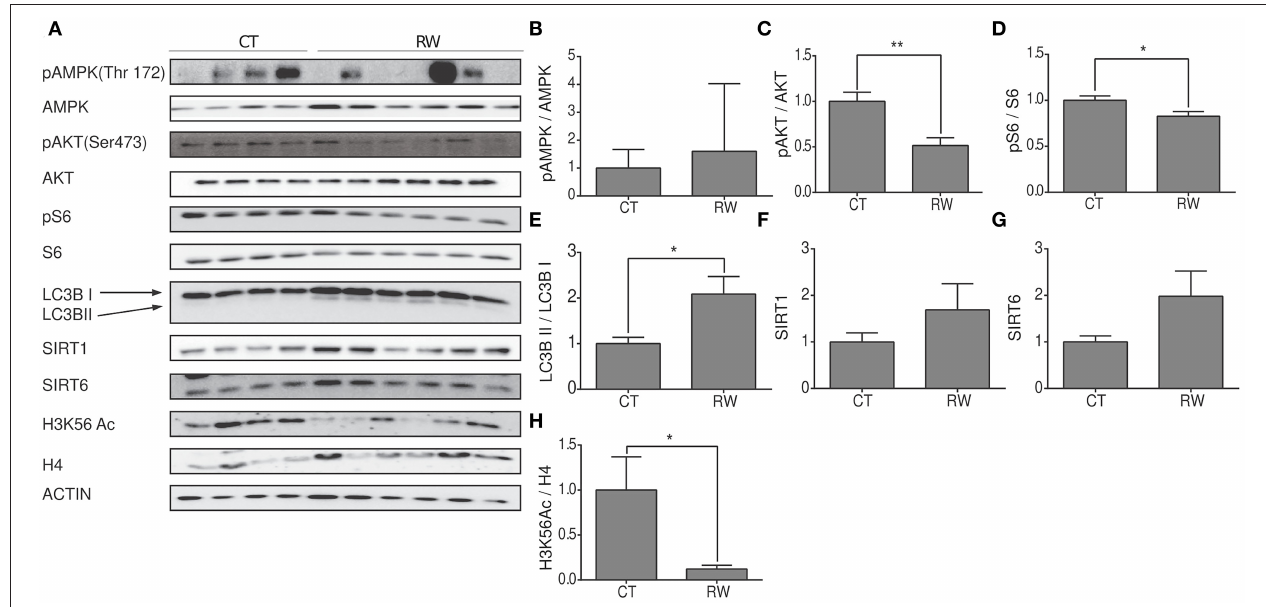
FIGURE 6 | Voluntary exercise activates AMPK, SIRT6, and autophagy in the hypothalamic region. (A) Representative Western blot analysis of p-AMPK, AMPK, pAKT, AKT, p-S6, S6, LC3B, SIRT1, SIRT6, and H3K56Ac in young (4 months) WT male mice in the hypothalamus at rest (CT) or under long-term voluntary exercise (RW). Densities of the bands were normalized to actin, which served as an internal control. (B) Phosphorylated AMPK normalized to unphosphorylated AMPK; (C) phosphorylated AKT normalized to unphosphorylated AKT. (D) Phosphorylated S6 normalized to unphosphorylated S6. (E) LC3B II protein expression normalized to LC3B I protein expression. (F) SIRT1 and (G) SIRT6 protein expression normalized to actin. (H) H3K56Ac normalized to H4 in the hypothalamus of young H4 in young (4-month-old) WT male mice. The values shown are mean ± s.e.m., * p < 0.05, ** p < 0.01; (two-tailed t -test). In (A–H) n = 4 for CT and n = 6